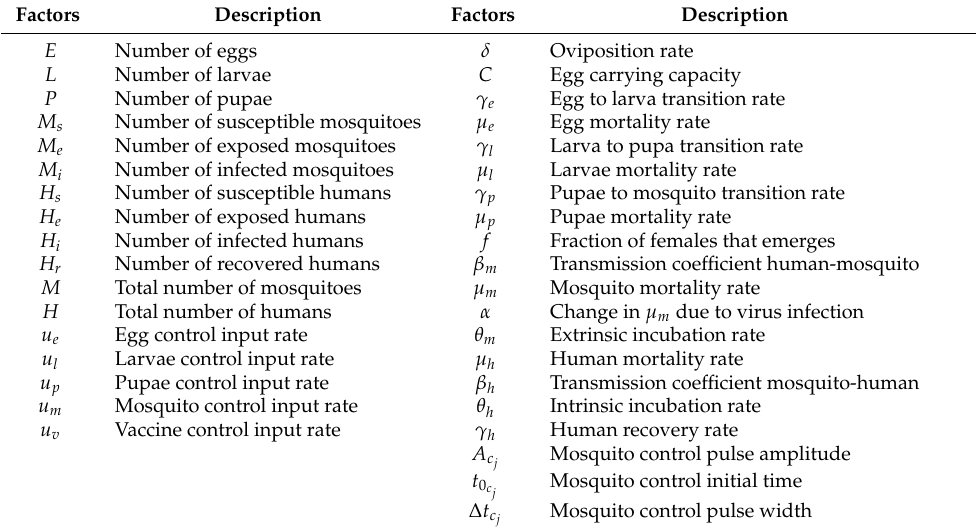
Table 1. Definition of state variables, parameters, and input variables for the mathematical model (1). The input that describes mosquitoes growth ( u m ) is defined by three parameters ( A c ∆ t c j ) in Equation (2); in addition, u m could be formed by multiple j pulse-type inputs as described in Section 2.4. Note that, for all factors, the time unit is one week, and the rate unit is [week − 1